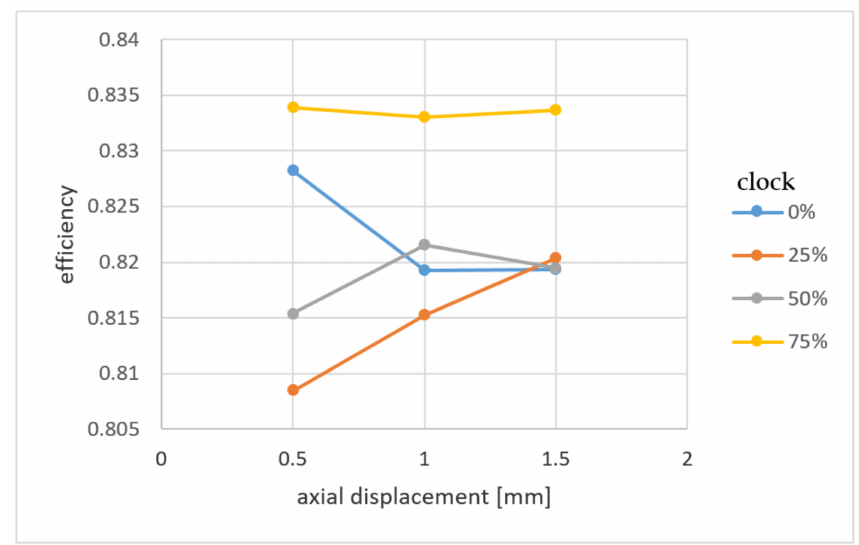
Figure 23. Axial inducer/exducer clearance vs.